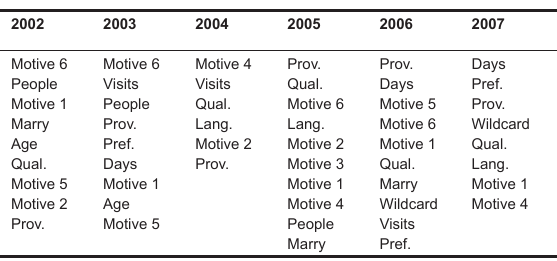
Table 4 Variables identified with stepwise regression from 2002 to